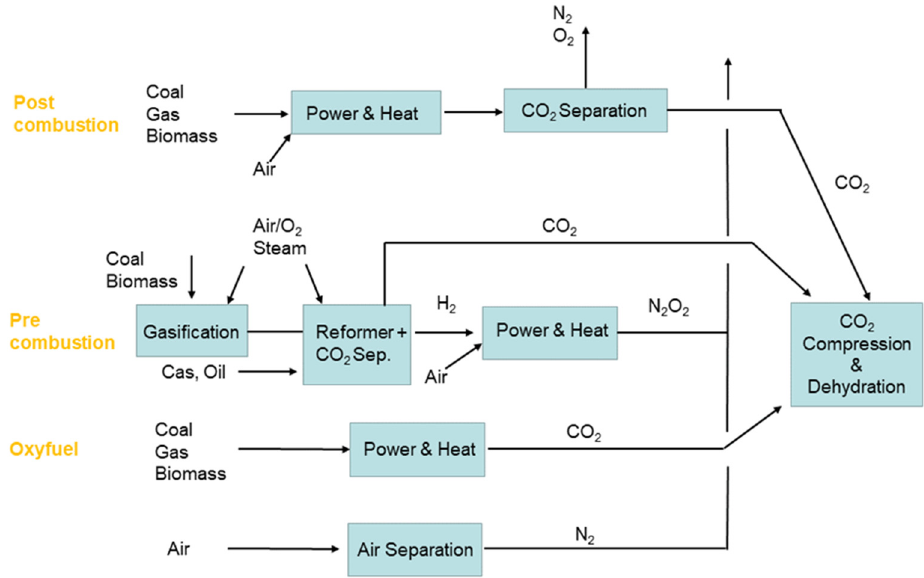
Figure 12. Illustration showing different approaches for capturing CO 2 from industrial sources